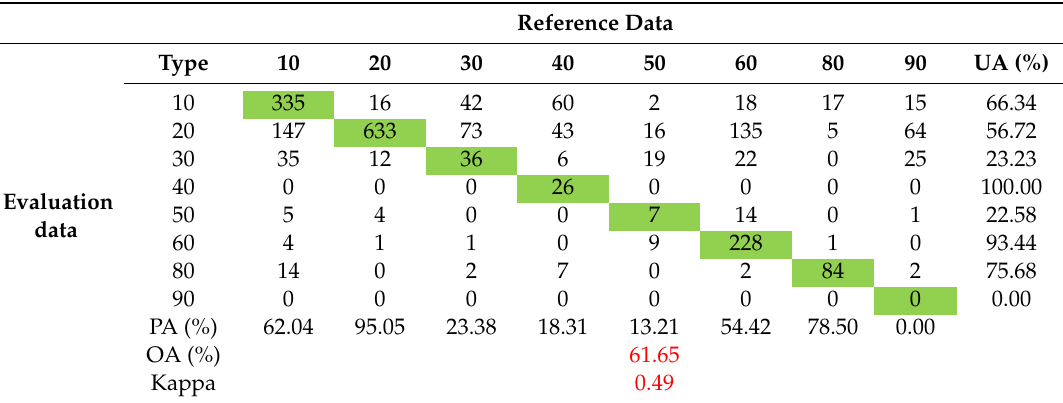
Table 10. GlobeLand30-2010 confusion